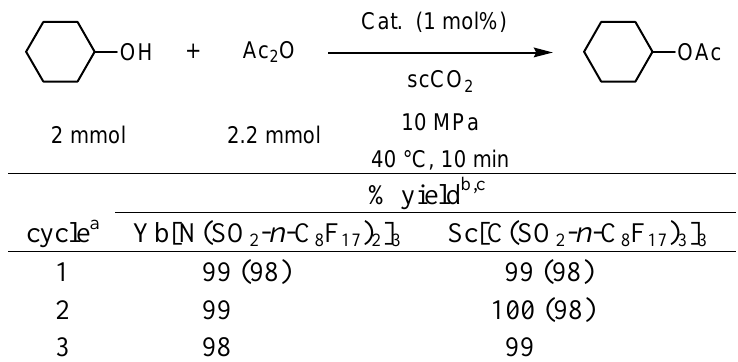
Table 7. Fluorous biphasic acetylation in scCO